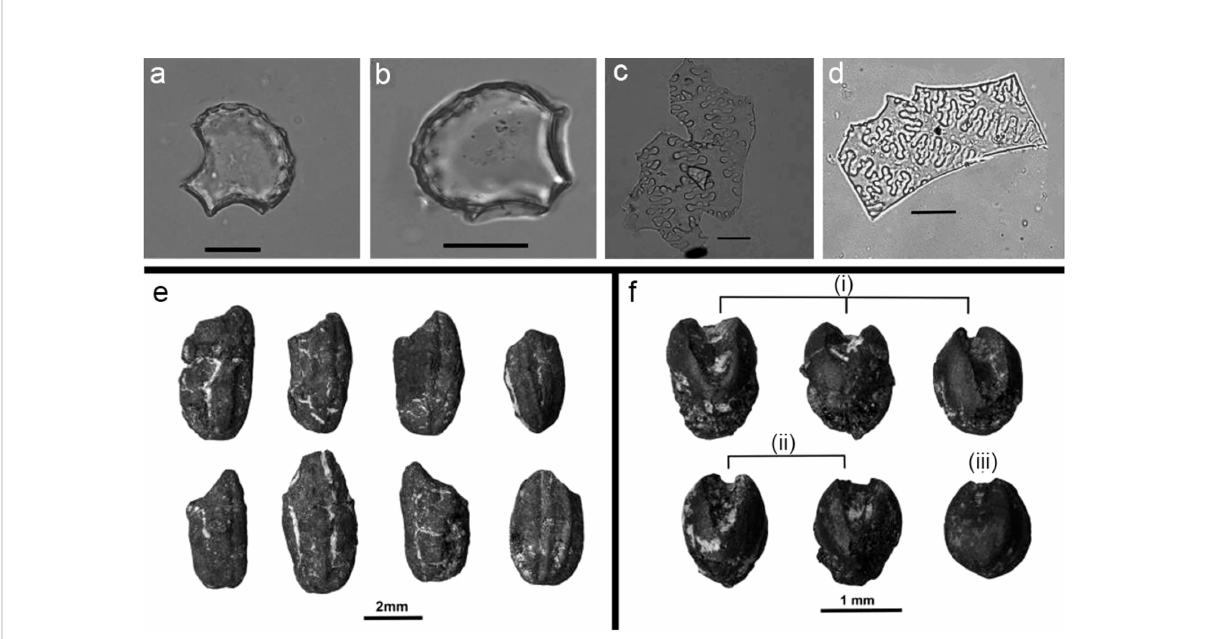
FIGURE 6 Phytoliths and macrofossil remains from rice and millet at the site of Qujialing (After Yao et al., 2019; Yang et al., 2020). A, B : cuneiform bulliform phytoliths from rice; C : W -undulated type, endings structures of epidermal long cell from foxtail millet; D : h -undulated type, endings structures of epidermal long cell from broomcorn millet (scale bar for fi gure 6a-d: 20 m m); E : macrofossil remains from rice during the Youziling Culture period; F (i) macrofossil remains from foxtail millet during the Youziling Culture period; F (ii) macrofossil remains from foxtail millet during the Qujialing Culture period; F (iii) macrofossil remains from foxtail millet during the Shijiahe Culture